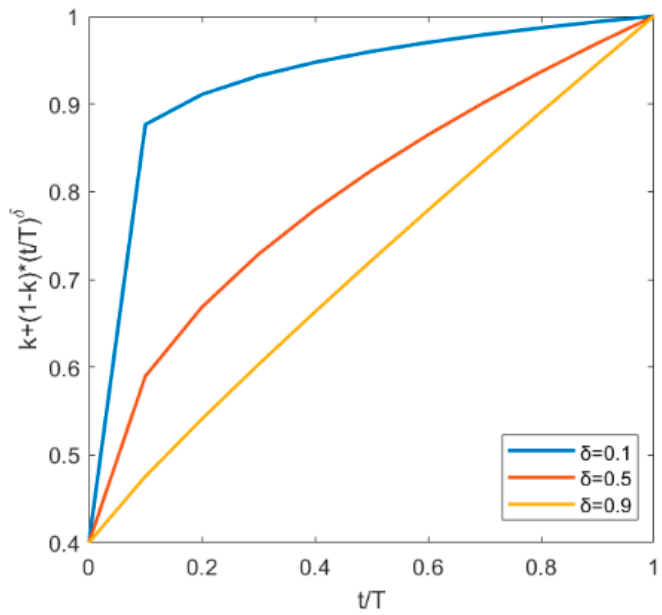
Figure 5. The influence of negotiation ability δ on k + ( 1 − k ) ∗ ( t / T ) δ . In the average convergence time experiment, we use the CAIDA IPv4 Routed/24 Topology Dataset [24] and extract some subgraphs from it for experiments. The specific parameters were set as follows: the link delay was 0.6 s, p = 0.9, δ = 0.7, k = 0.5, and T = 3. The purpose of the experiment is to investigate the changes in the average convergence time of BNTE-BG, BGP, and NS-BGP mechanisms as the size of the AS topology changes. The experimental results are shown in Figure 6.